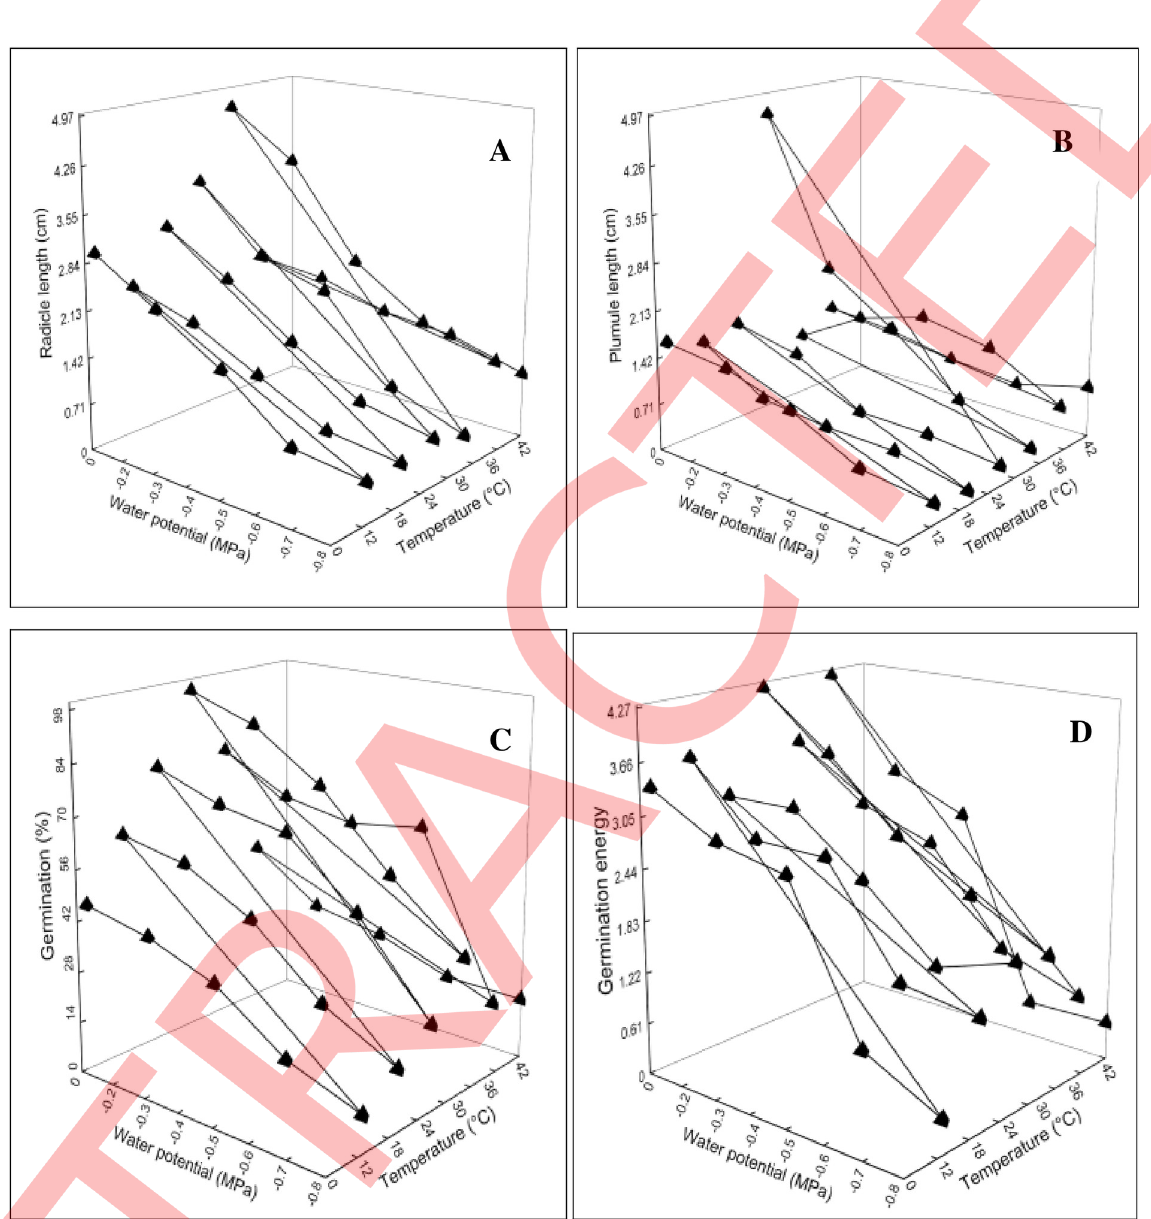
Fig 2. Interactive effect of water potential and temperature on (A) Radicle length (B) Plumule length (C) Germination percentage (D) Germination energy of chickpea var. NIFA 1995.